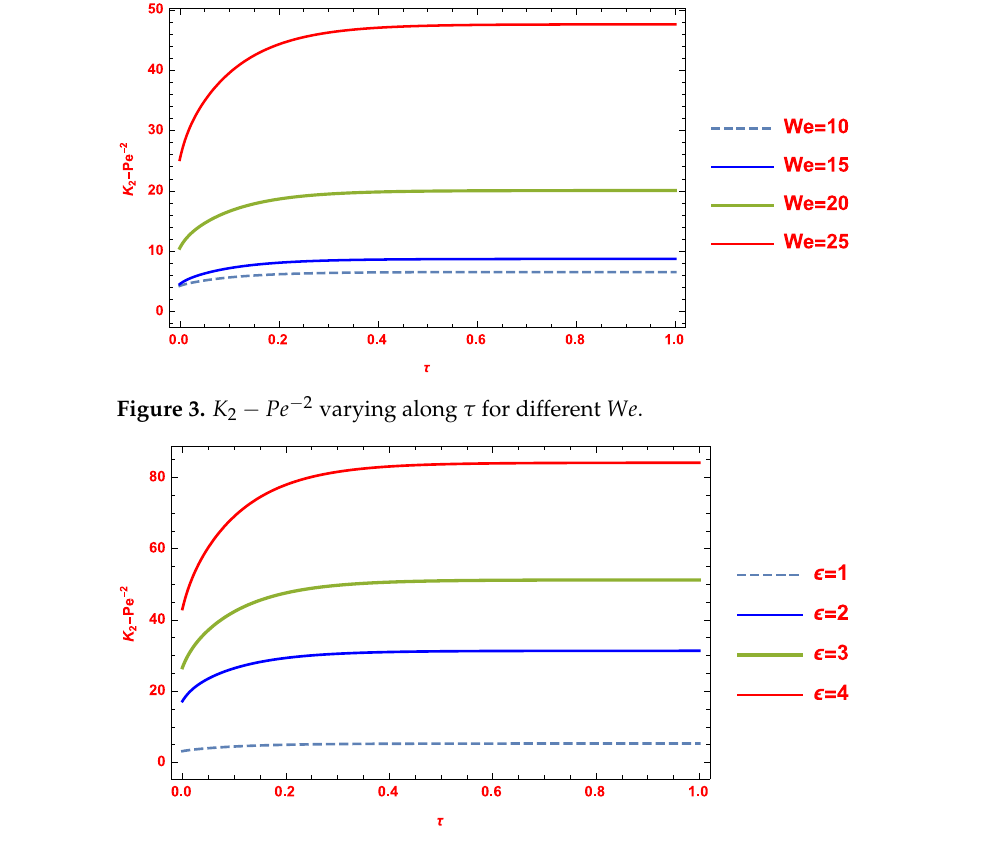
Figure 4. K 2 − Pe − 2 varying along τ for different (cid:101) .